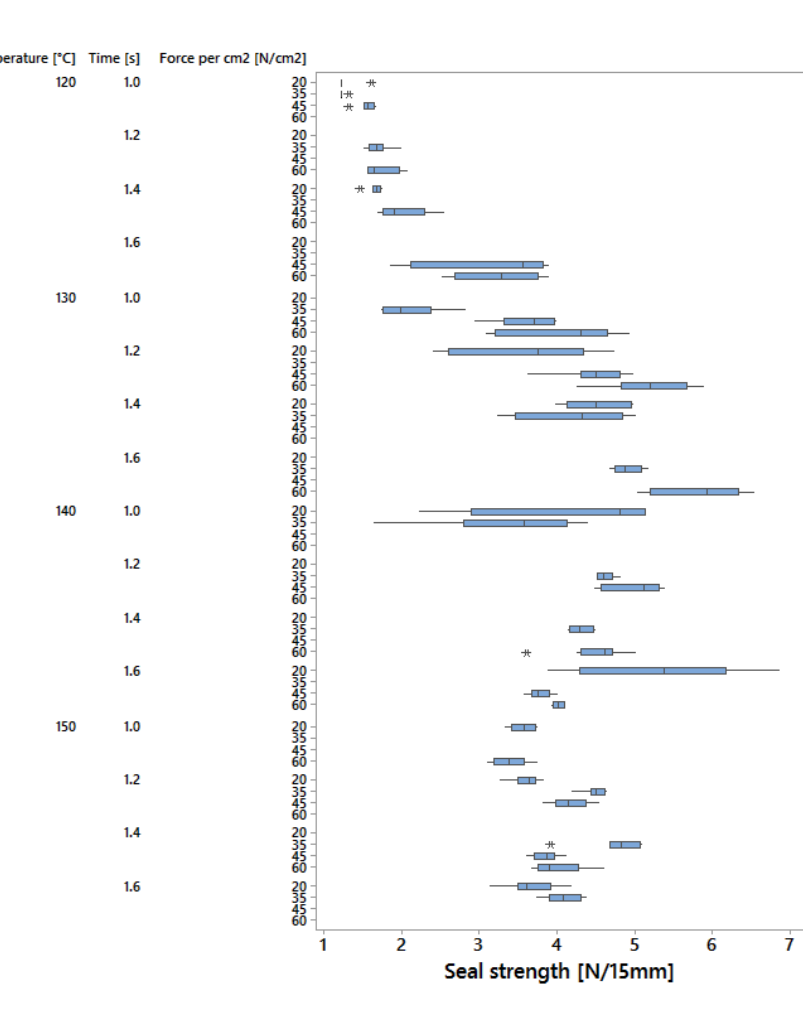
Figure 11 – Boxplot of Seal strength according to factors levels